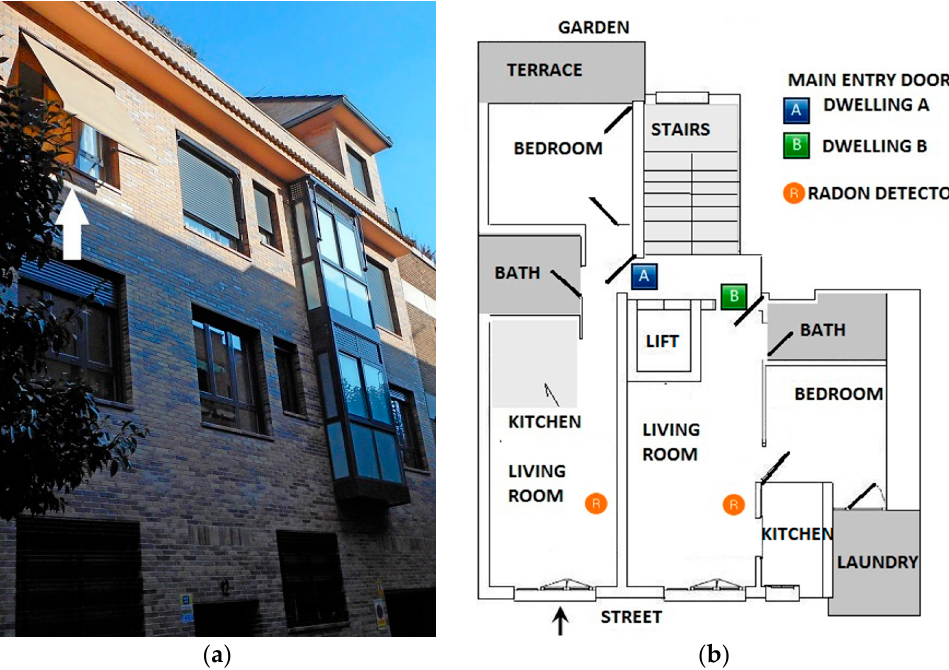
Figure 1. ( a ) Picture taken in the year 2018 showing the building’s facade. A white arrow points to the location of the living room window of dwelling “A”. This marker can be used as a visual reference point because it is also marked in the right diagram. ( b ) Floor plan of the dwelling units.